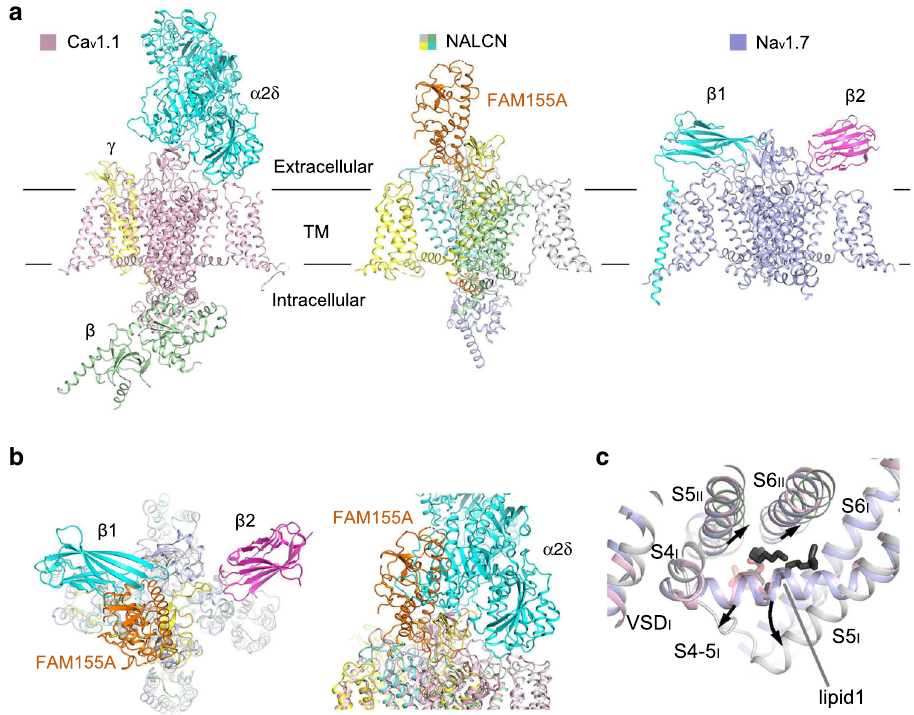
Fig. 2 Structural comparisons between NALCN and Na v /Ca v channels. a Overall structures of human NALCN, human Na v 1.7 (PDB: 6J8I), and rabbit Ca v 1.1 (PDB: 6JP5). The ion conducting subunits of Na v 1.7 and Ca v 1.1 are colored slate and light pink, respectively. The auxiliary subunits β 1 and β 2 of Na v 1.7 are colored cyan and magenta, and the auxiliary subunits α 2 δ , β , γ of Ca v 1.1 are colored cyan, yellow, and green, respectively. b FAM155A adopts a unique binding site on NALCN that differs from the auxiliary subunits of Na v /Ca v channels. The structure of NALCN is superimposed with Na v 1.7 or Ca v 1.1 based on the ion-conducting subunit of each complex. Na v 1.7 is shown in an extracellular view (left), and Ca v 1.1 is shown in a side view (right). c Structural features in repeat I and a unique lipid-binding site of NALCN. The S4-5 I linker of NALCN is a loop instead of a helix in Na v 1.7/Ca v 1.1. S5 I in NALCN is extended three-helix turns into the cytosol compared to that of Na v 1.7/Ca v 1.1. An identi fi ed lipid molecule in NALCN occupies a position that corresponds to the S4-5 helix in Na v 1.7/Ca v 1.1. Local structural deviations around the lipid between NALCN and Na v 1.7/Ca v 1.1 are indicated by black